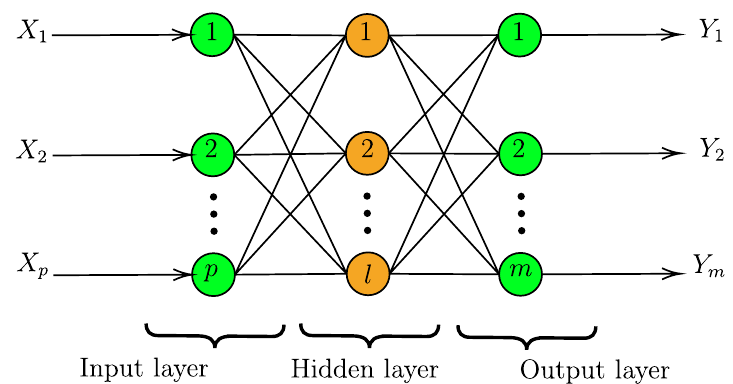
Fig. 13 ELM NN for channel estimation in MIMO-OFDM